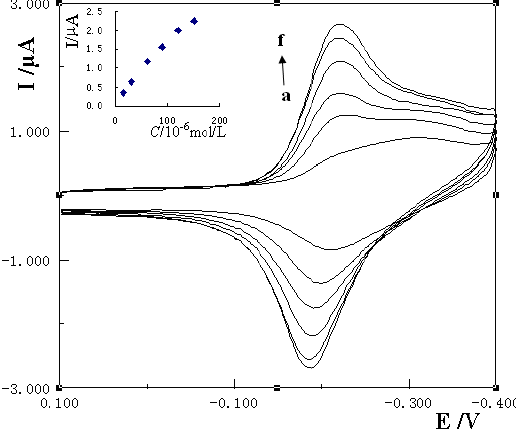
Figure 2 . Influence of MB concentrations on peak current of ssDNA/MAA/Au electrode.